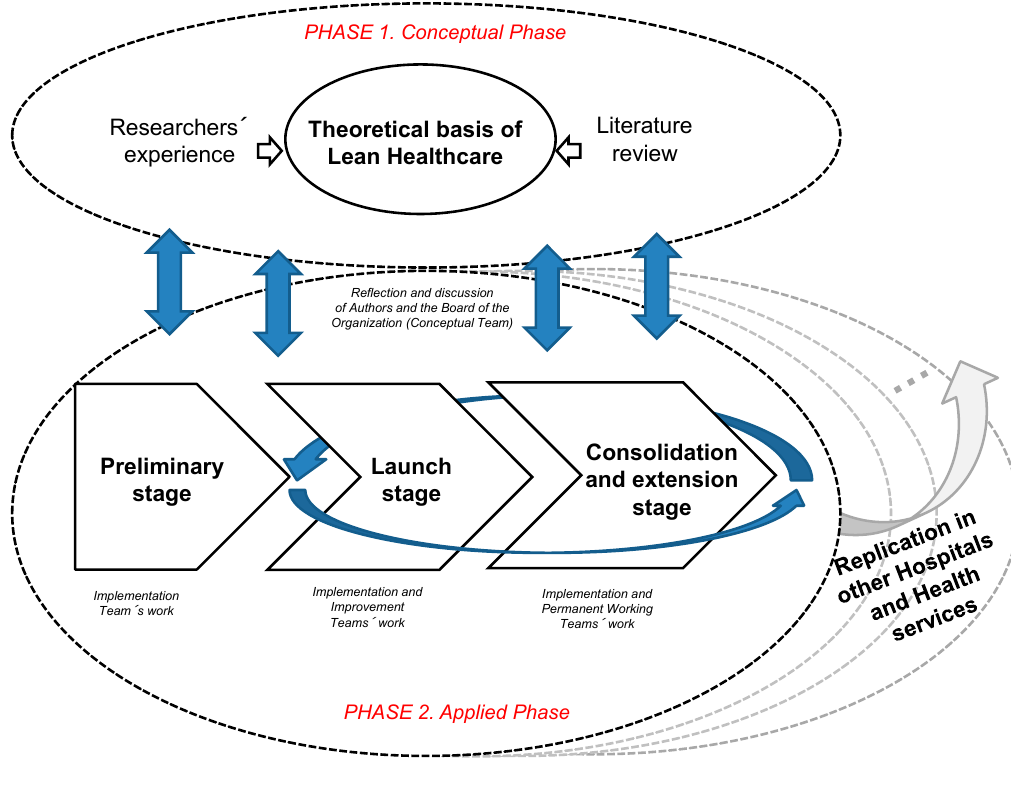
Figure 1. Proposal of the participative methodology.